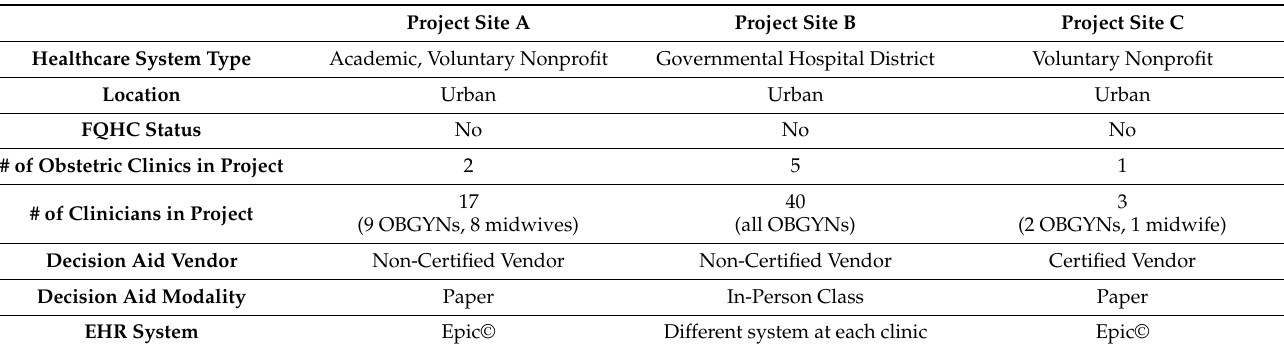
Table 1. Profiles of the project